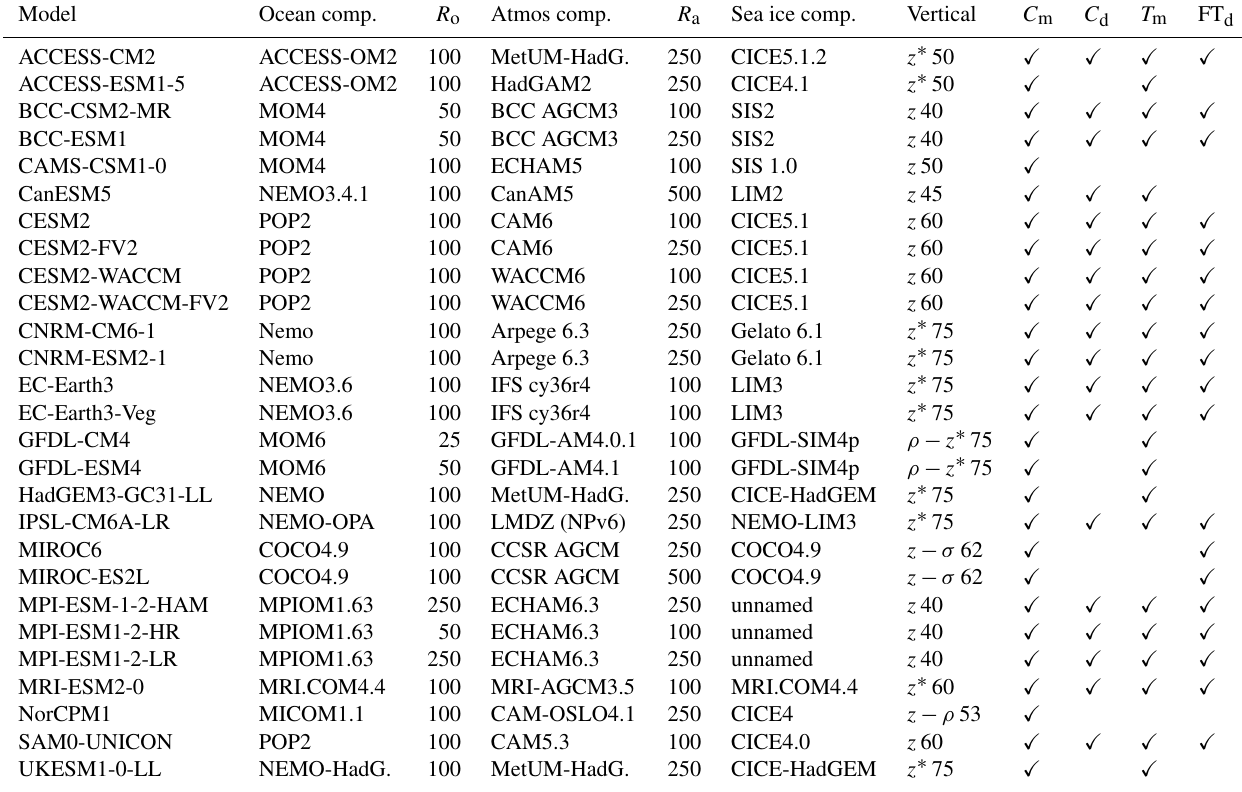
Table 1. The 27 CMIP6 models used in this study. Columns show the model names, ocean component, nominal horizontal resolution of the ocean ( R o [km]), atmosphere component, horizontal resolution of the atmosphere ( R a [km]), sea ice component, vertical discretisation scheme including number of vertical levels ( z : depth level, ρ : isopycnal, σ : terrain-following, several symbols: hybrid grid), data availability of monthly sea ice concentration ( C m ), daily sea ice concentration ( C d ), monthly sea ice thickness ( T m ) and daily sea ice floe thickness (FT d